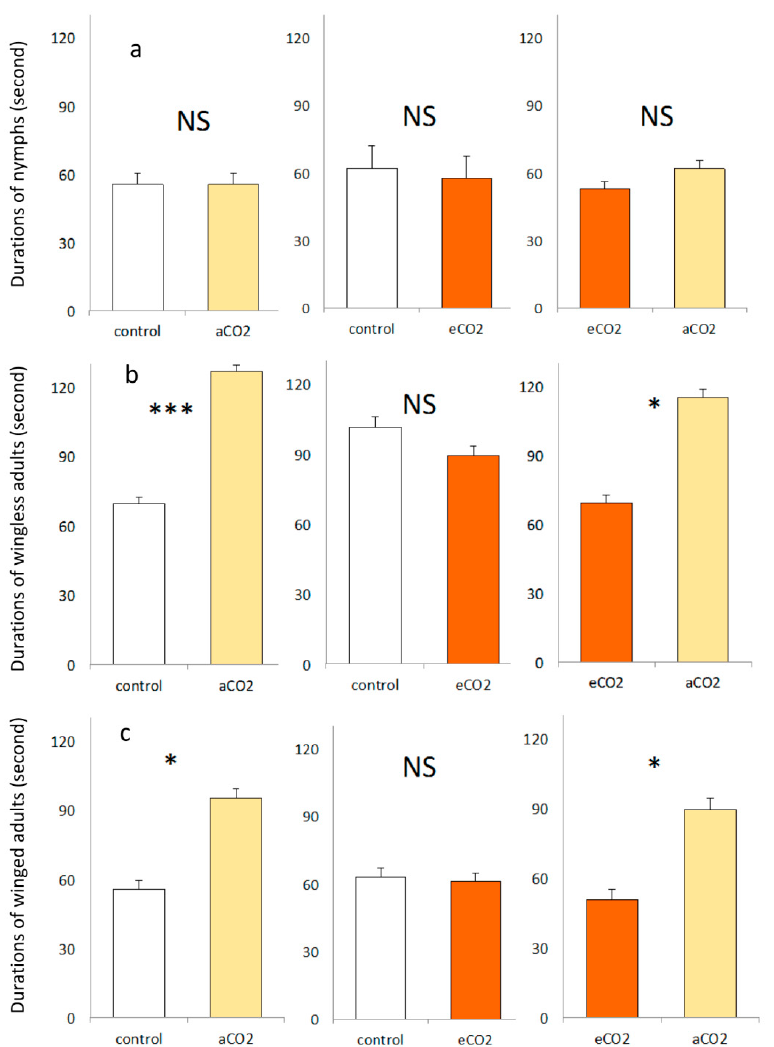
Figure 2. (mean ± se) of nymph ( a ), wingless ( b ) and winged ( c ) corn leaf aphid during three dual choices including control, aCO 2 and eCO 2 barley seedling combinations. There were three replicates for each treatment, and a total of 180 aphids were tested. *, *** and NS for p ≤ 0.05, p ≤ 0.001 and not significant at α = 0.05,